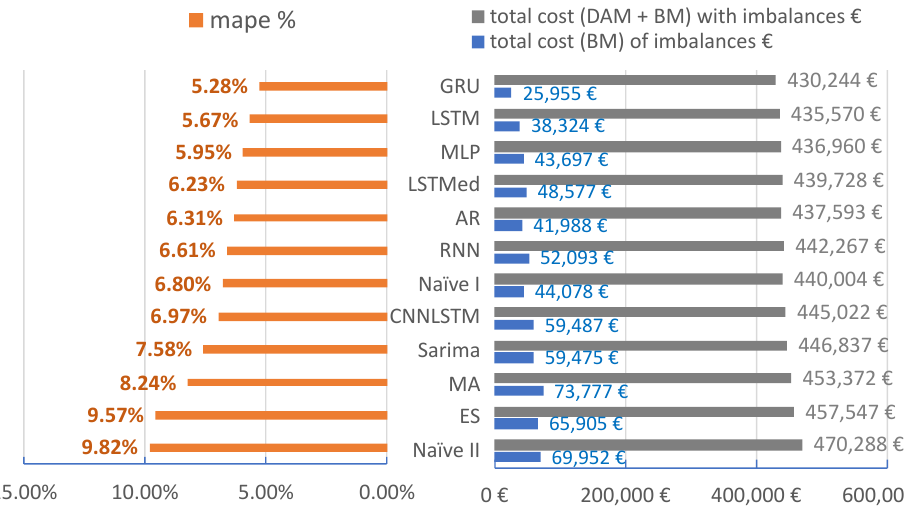
Figure 21. Comparison of MAPE metric with the cost of the errors on the power market. The period analyzed is from 15 October 2019 to 20 December 2019. Total cost with imbalances includes the acquisition from the DAM and BM, and the total cost of imbalances represents only the cost generated by buying or selling on the